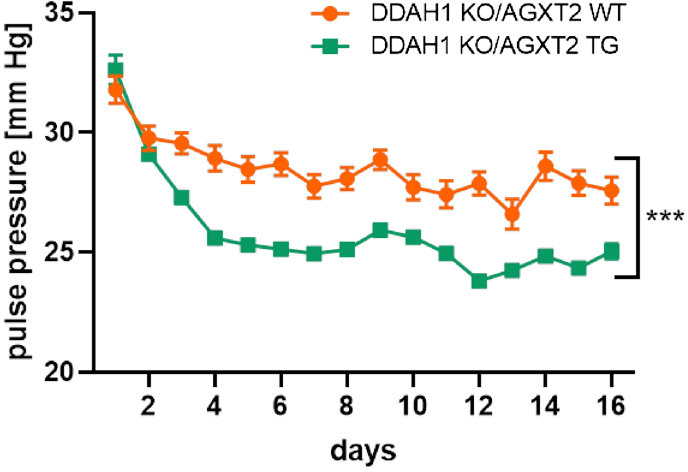
Figure 6. Pulse pressure in DDAH1 KO/AGXT2 WT and DDAH1 KO/AGXT2 TG mice. The recordings in the first 7–8 days can be influenced by stress after implantation of the sensor and the transmitter. Repeated-